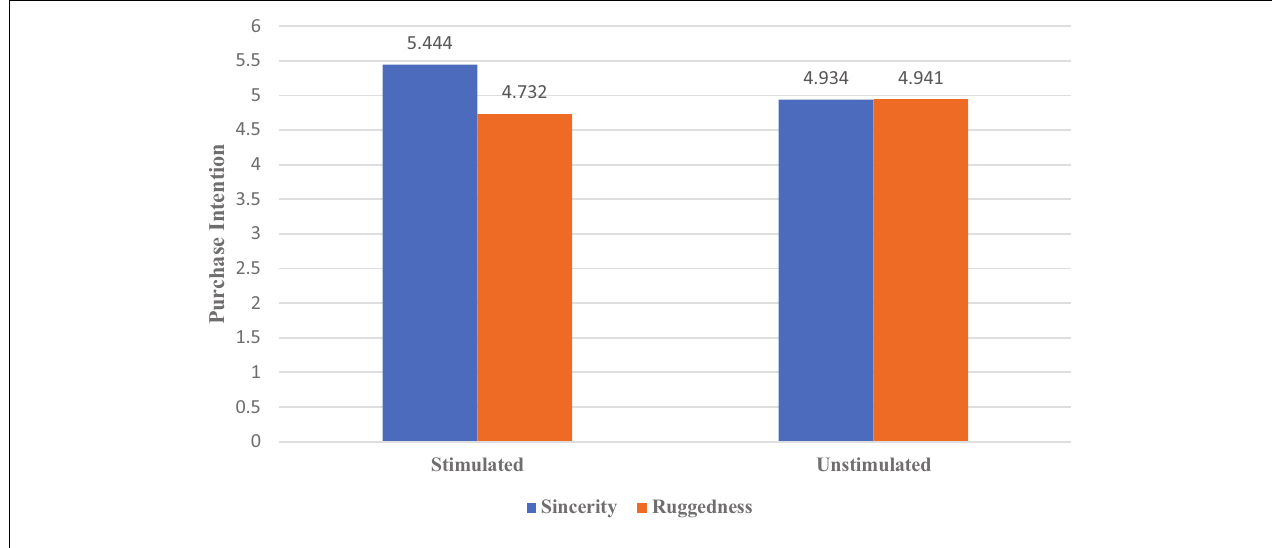
FIGURE 3 | The effect of erotic stimulation on women’s preference for brand